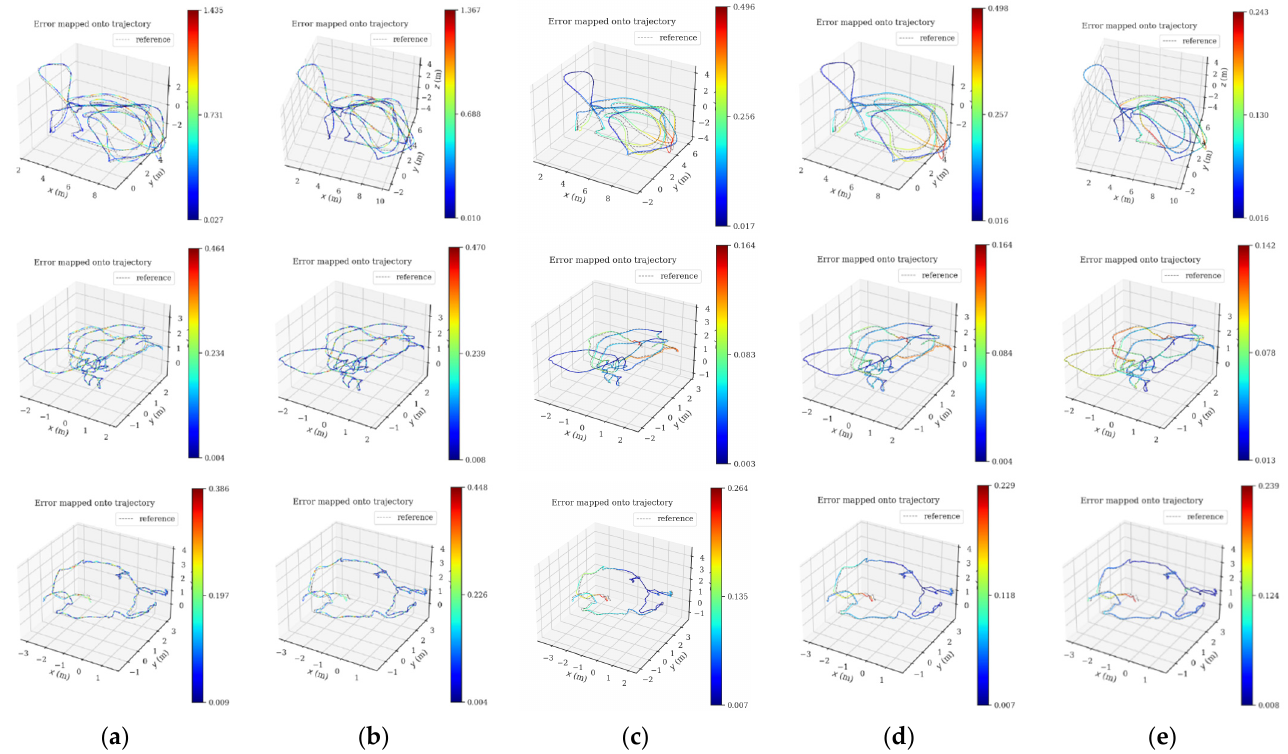
Figure 7. Pose error trajectory comparison of VINS-Mono and ours W/and W/O loop algorithms under sequence MH_03_medium, V1_01_easy and V2_01_easy. The color of the track changes from blue to red, and the closer the color is to red, the greater the error. The gray dotted line is the trajectory truth: ( a ) VINS-Mono w/o loop; ( b ) VINS-Mono; ( c ) ours (length gilter) w/o loop; ( d ) ours (length filter and line merge) w/o loop; ( e ) ours.